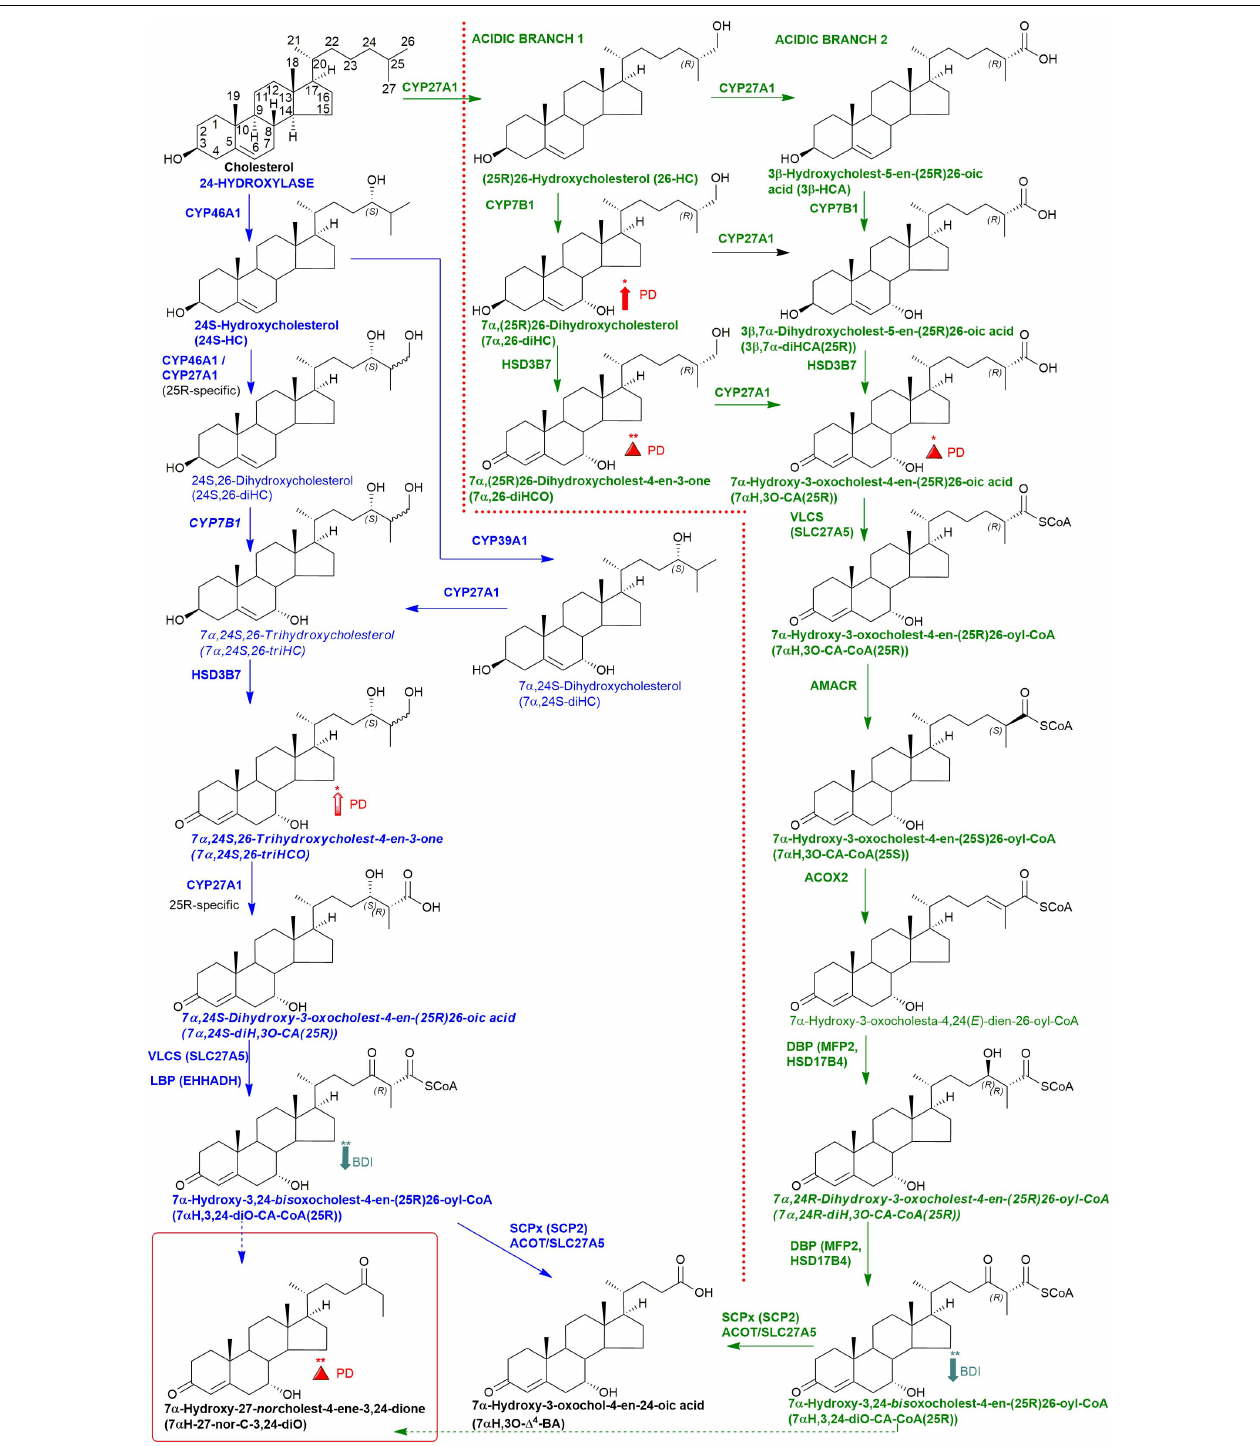
FIGURE 1 | Abbreviated versions of the cerebral 24-hydroxylase (left) and acidic (right) pathways of bile acid biosynthesis. Enzymes, metabolites, and reactions of the 24-hydroxylase pathway are indicated in blue, those of the acidic pathway are in green. Enzymes/genes expressed in the brain, and metabolites observed, in CSF are in bold. CoA intermediates are observed as the unconjugated acids in CSF. Italics indicate that the named structure is one of a number of possibilities. The broken arrows indicate a reaction leading to elimination of C-27. Thick coloured arrows pointing upwards or downwards indicate significant positive or negative correlations even when the confounding variables are considered. Red triangles indicate significance ignoring confounding variables, in at least one of the two studies. The full stereochemistry and numbering system for cholesterol is indicated. Abbreviated structures are shown for other sterols ignoring ring-stereochemistry.